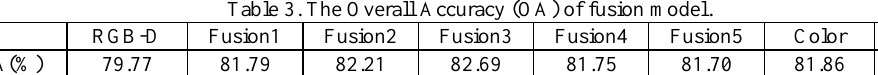
Table 3. The Overall Accuracy (OA) of fusion model.